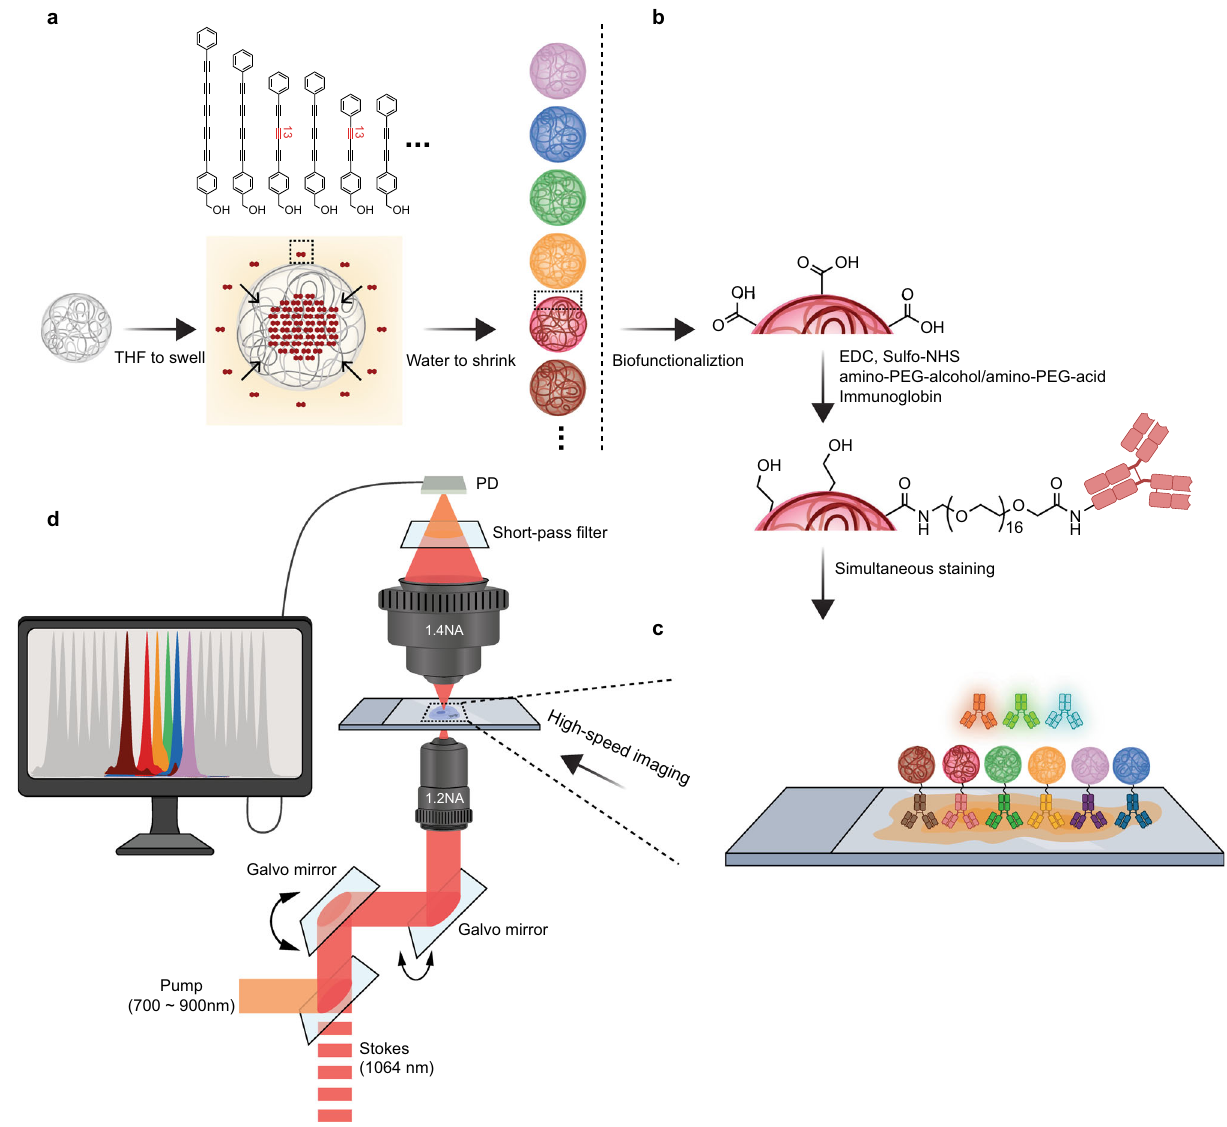
Fig. 1 Schematics of preparing Rdots and their biofunctionalization. a 20 nm polystyrene (PS) nanoparticles are fi rst swelled in organic solvents such as tetrahydrofuran (THF), and small-molecule Raman probes are allowed to diffuse into the nanoparticles, followed by shrinking the nanoparticles to entrap the Raman probes to generate Rdots. The dense packing of Raman probes inside nanoparticles makes Rdots ultra bright. b For easy biofunctionalization, Rdots are fi rst conjugated with a mixture of amine-PEG8-alcohol and amine-PEG16-acid through EDC/NHS coupling to react with abundant carboxyl groups on the surface. Such combination of the two PEG chains can help reduce the non-speci fi c binding and aggregation. Then IgG or other amine bearing bio-molecules are conjugated to the carboxyl groups from PEG-acids. This two-step procedure helps to increase the hydrophilicity and to greatly reduce non-speci fi c binding. c Simultaneous immunostaining of Rdots and fl uorescence probes (shown in shaded antibodies). d Multiplexed imaging with stimulated Raman scattering (SRS) microscopy, thanks to the narrow peak width of